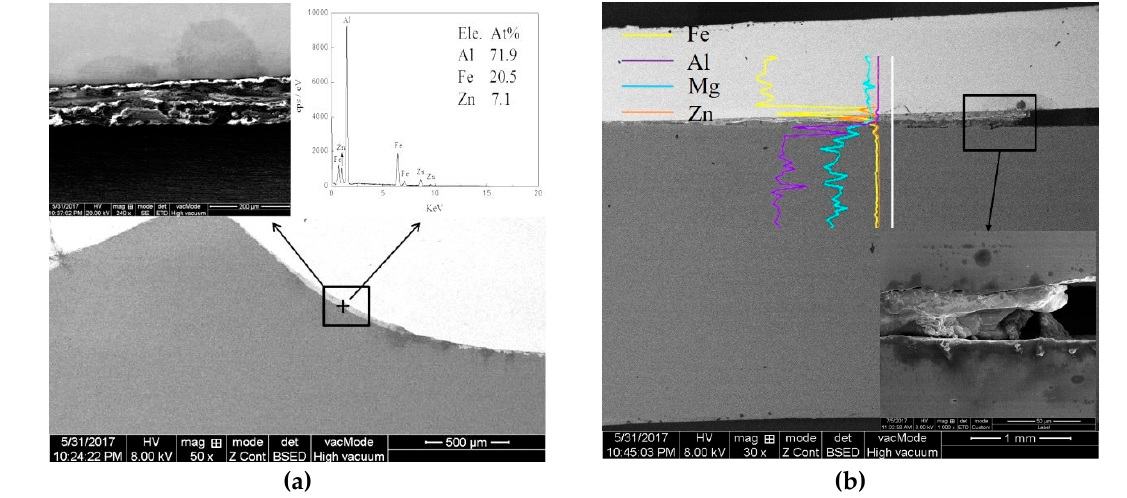
Figure 9. Micromorphology and energy-dispersive spectrometer (EDS) of the interface of the keyhole-free FSSW joint: ( a ) center area and ( b ) edge area.